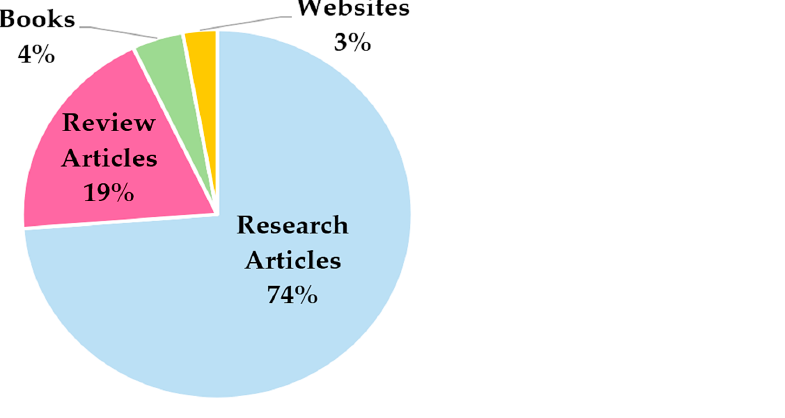
Figure 2. Distribution of the documents selected for structuring the presented review paper on smart devices for monitoring rehabilitation and tracking sports activities.